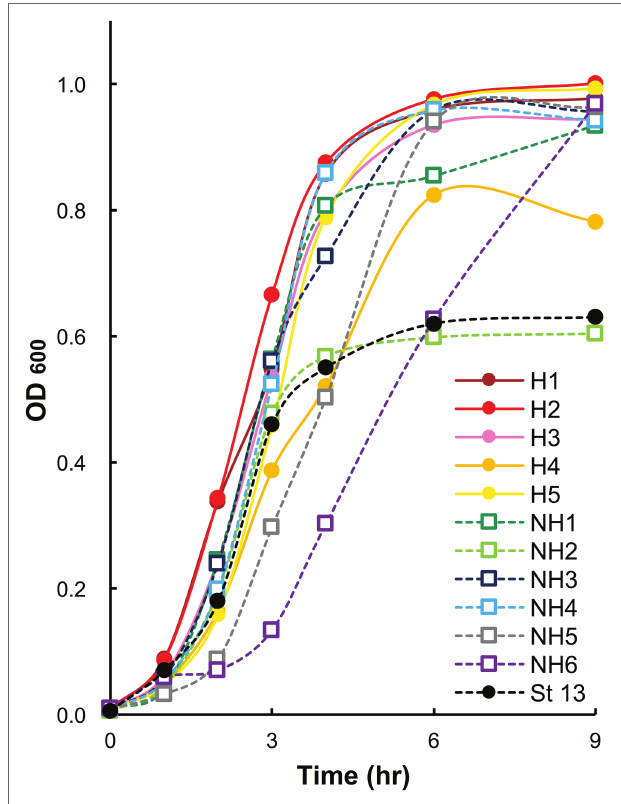
FIGURE 1 | Growth curves of blood-derived clinical isolates. Clinical isolates in stationary phase were inoculated at a 1% concentration, and bacterial growth was assessed by measuring the change in the absorbance of the aliquots at 600 nm. OD 600 : optical density at 600 nm. In the graph, strains in group H are shown with solid circles and solid lines, strains in group NH with open squares and dashed lines, and strain 13 with black markers and a dashed line. Group H, massive intravascular hemolysis group; Group NH, nonhemolysis